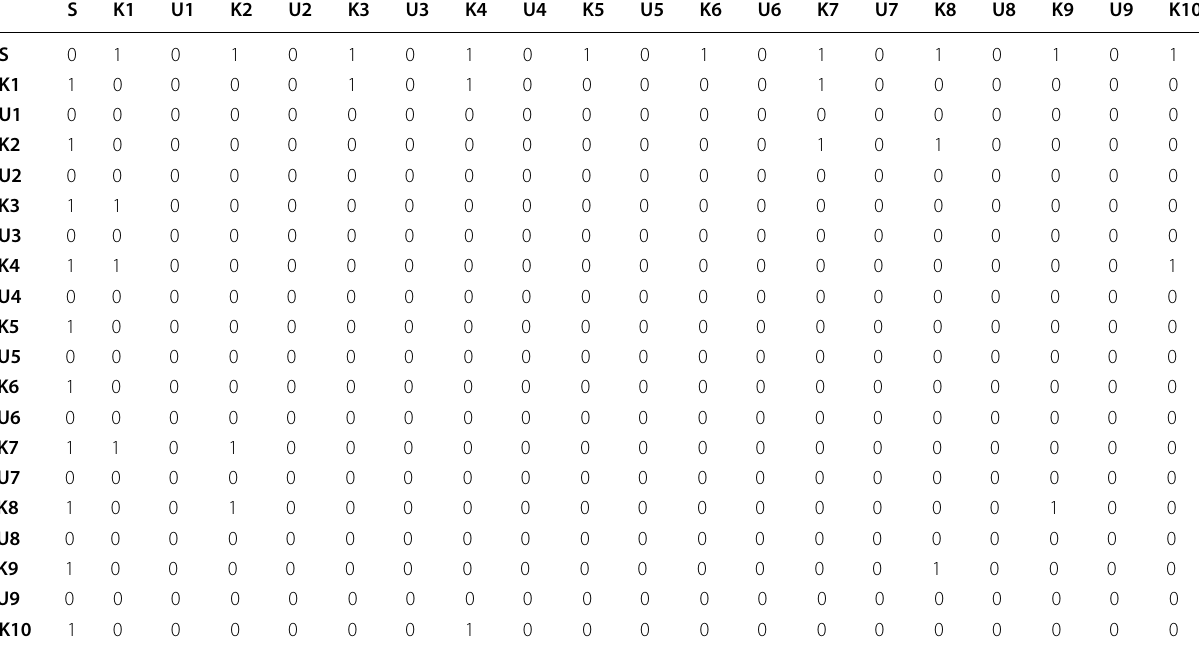
Table 2 Adjacency Matrix based on NCM (Fig. 6)